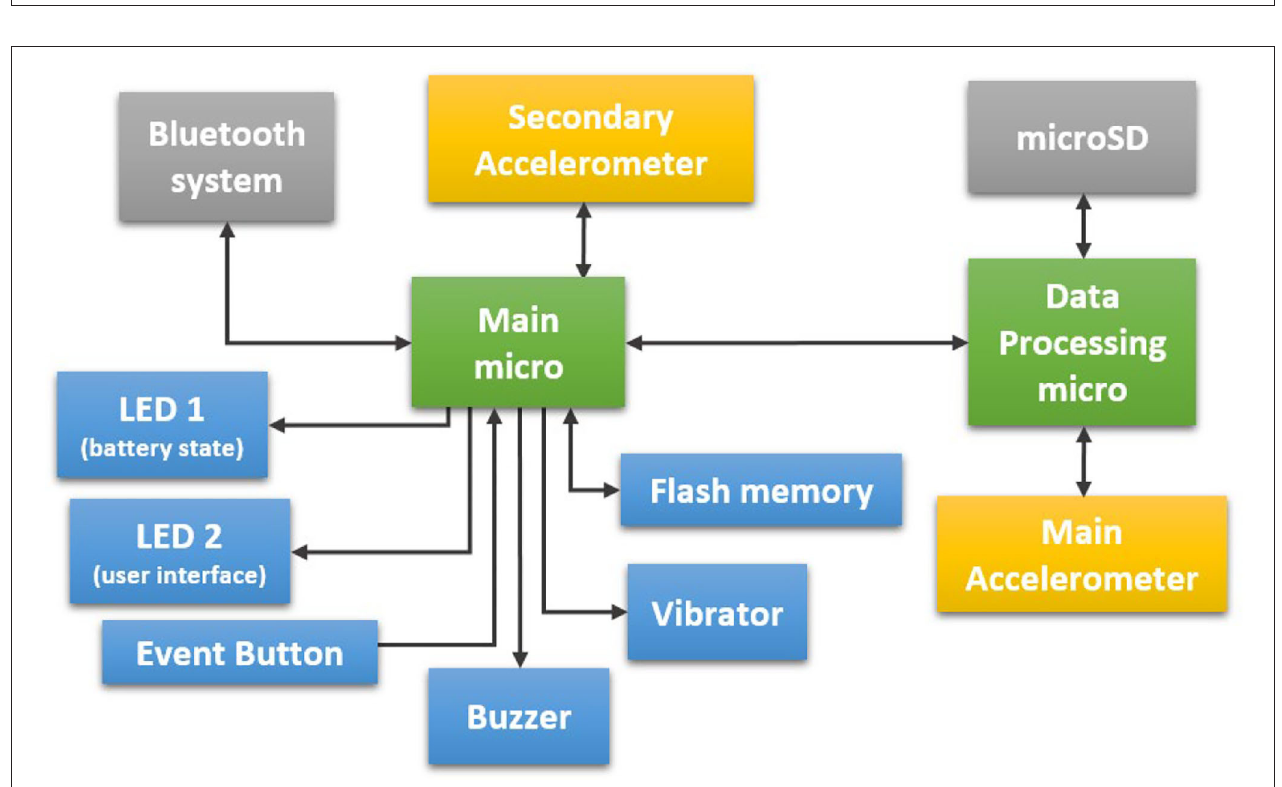
FIGURE 3 | STAT-ON TM ′ s internal